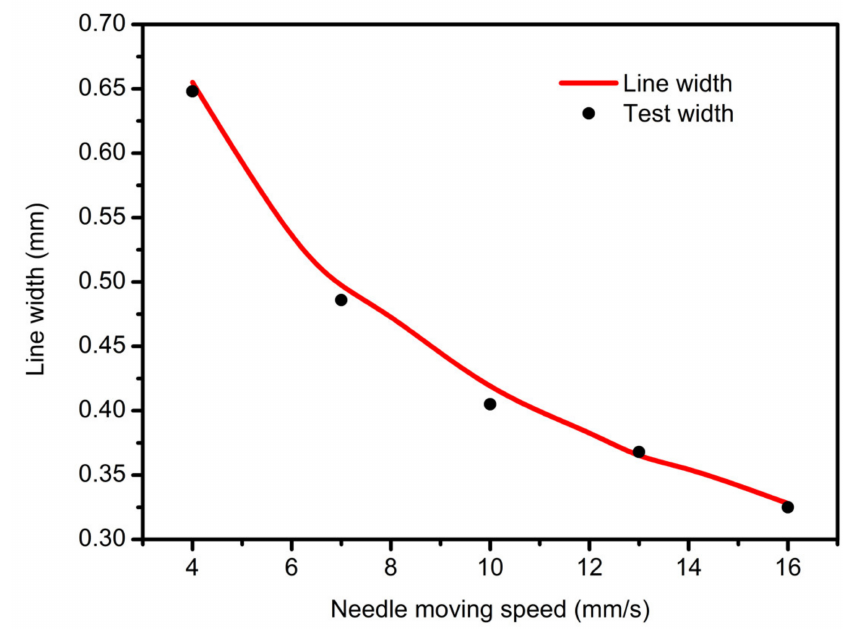
Figure 9. The relationship between the nozzle moving speed and line